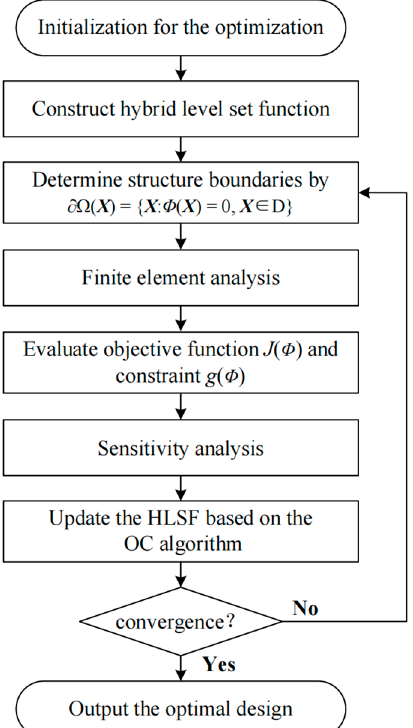
Figure 6. Flowchart of the optimization procedure.